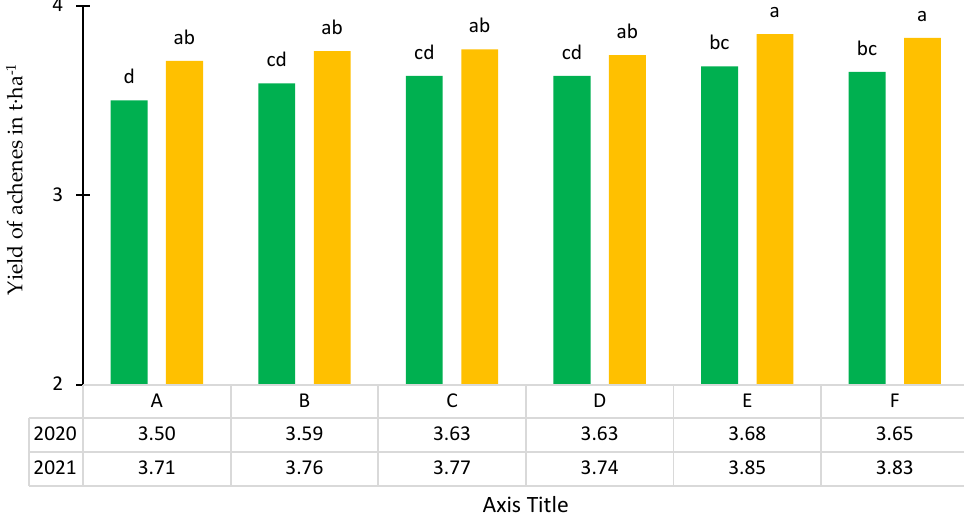
Figure 6. Yield of achenes in t · ha − 1 . A–F—variants of fertilization. Different lowercase letters indicate significant differences ( p < 0.05) according to the analysis of variance (ANOVA).